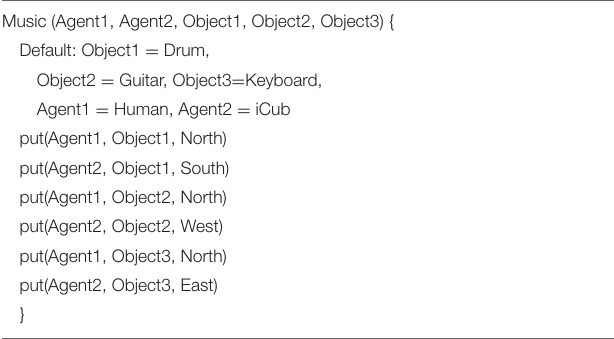
TABLE 1 | Readable representation of a shared plan for a music game that was learned by the iCub via demonstration and spoken language. Music (Agent1, Agent2, Object1, Object2, Object3)